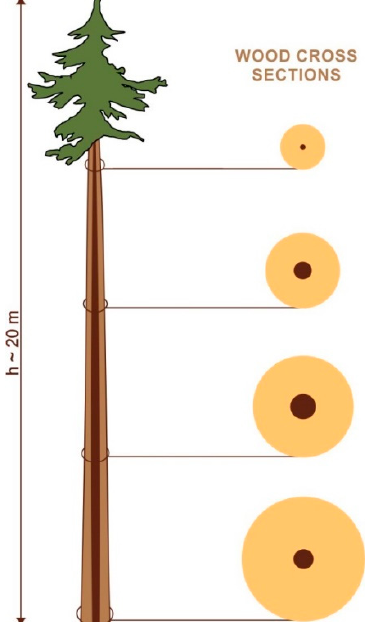
Figure 2. A schematic diagram showing the proportion of SW and HW along the stem axis of a 20 m high (h) Pinus sylvestris tree. The proportion of SW and HW is based on the number of annual rings. The axial distance between the cross sections shown is ca. 4 m. SW—light brown, HW—dark brown.